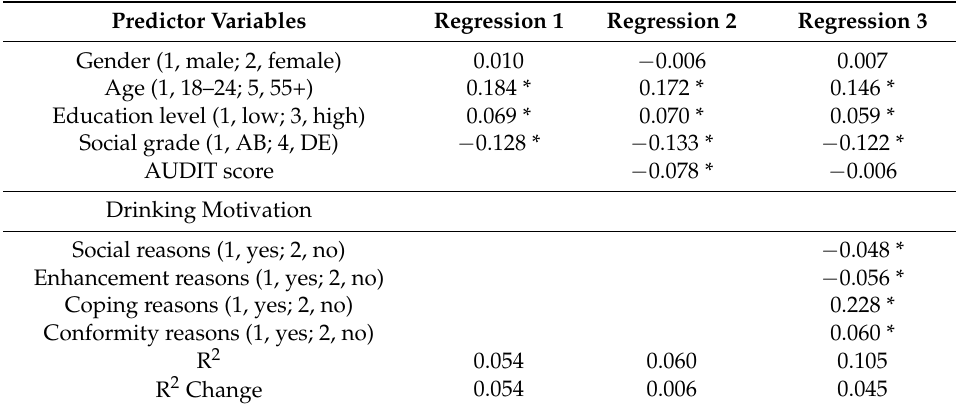
Table 5. Hierarchical multiple regression analysis of predictors of wellbeing.